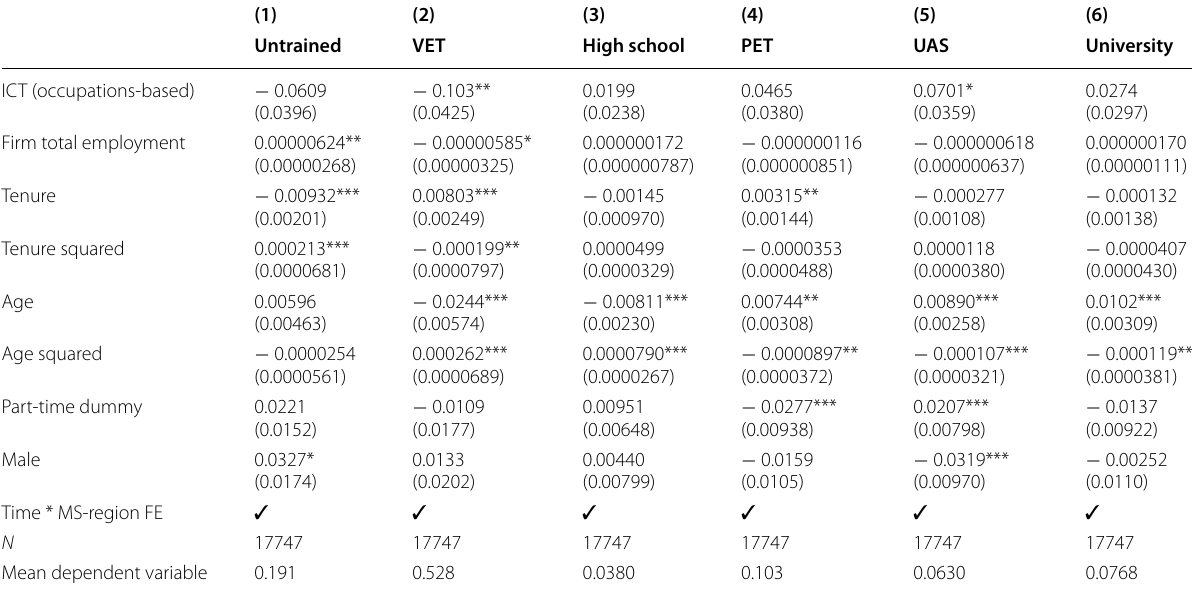
The table shows OLS coefficients of fixed effects estimates of a firm pseudo-panel with cells defined based on MS-region, industry, and firm size. Standard errors in parentheses are clustered at the cell level. N reports the number of pseudo-panel cells that contain at least one firm. The main explanatory variable measures the cell